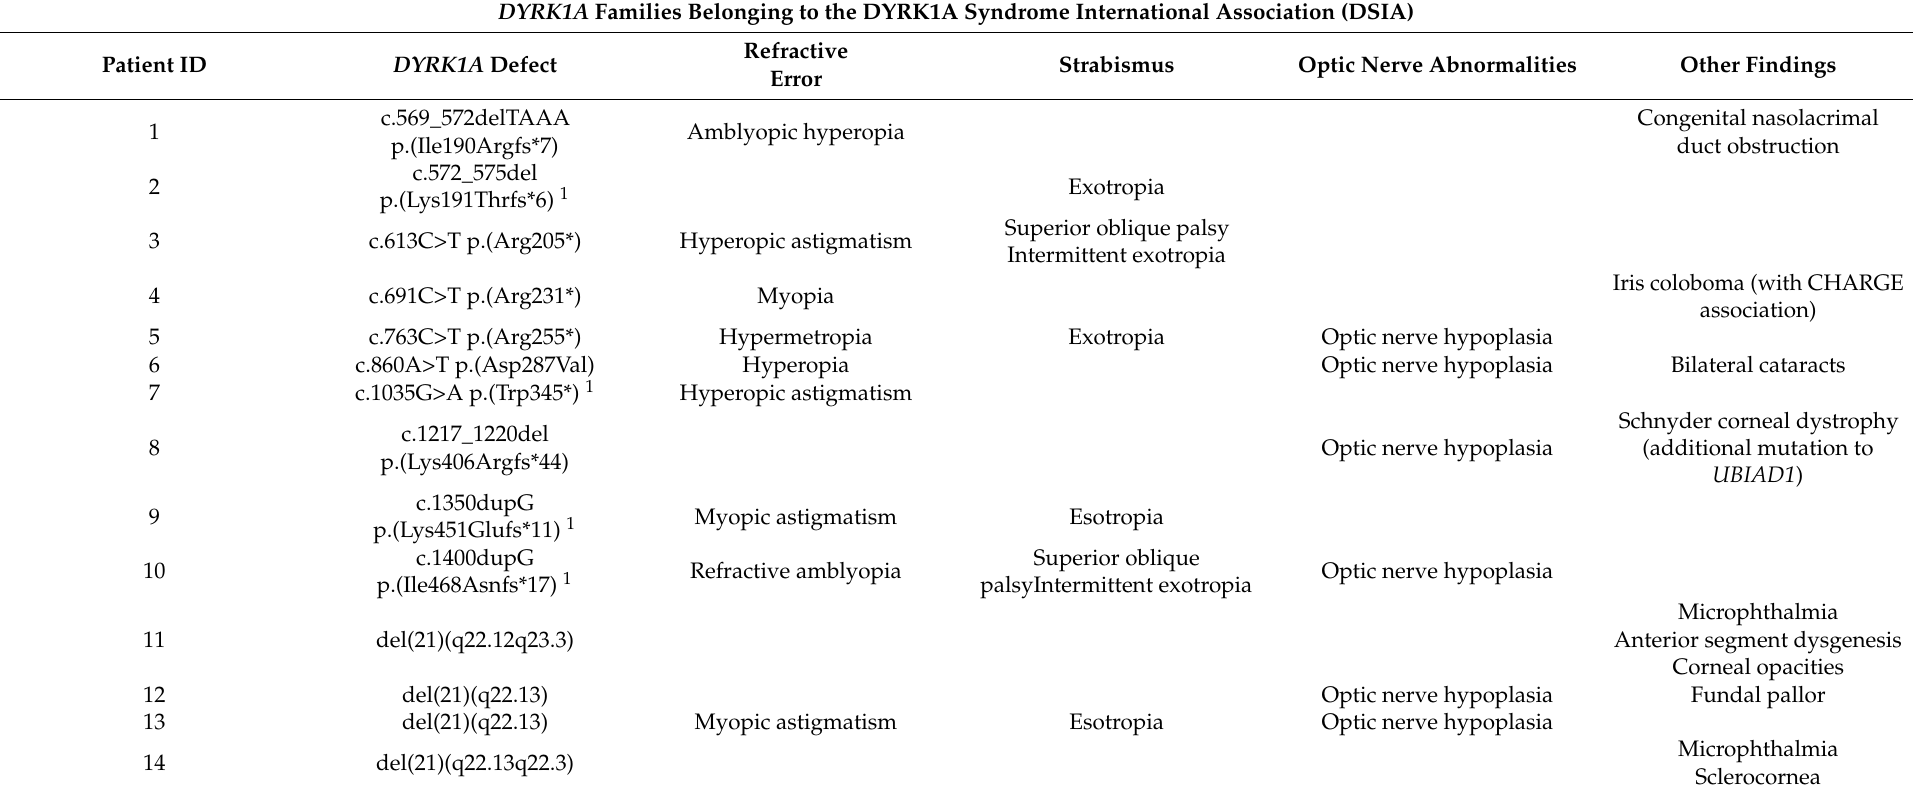
Table 1. Ocular findings in patients with DYRK1A -related intellectual disability syndrome, from online patient group and from the UK Genomics England Ltd. 100,000 Genomes Project [37]. Fourteen patients and their guardians provided the full request of ocular diagnoses and mutation analysis. Nine patients with DYRK1A -related intellectual disability syndrome